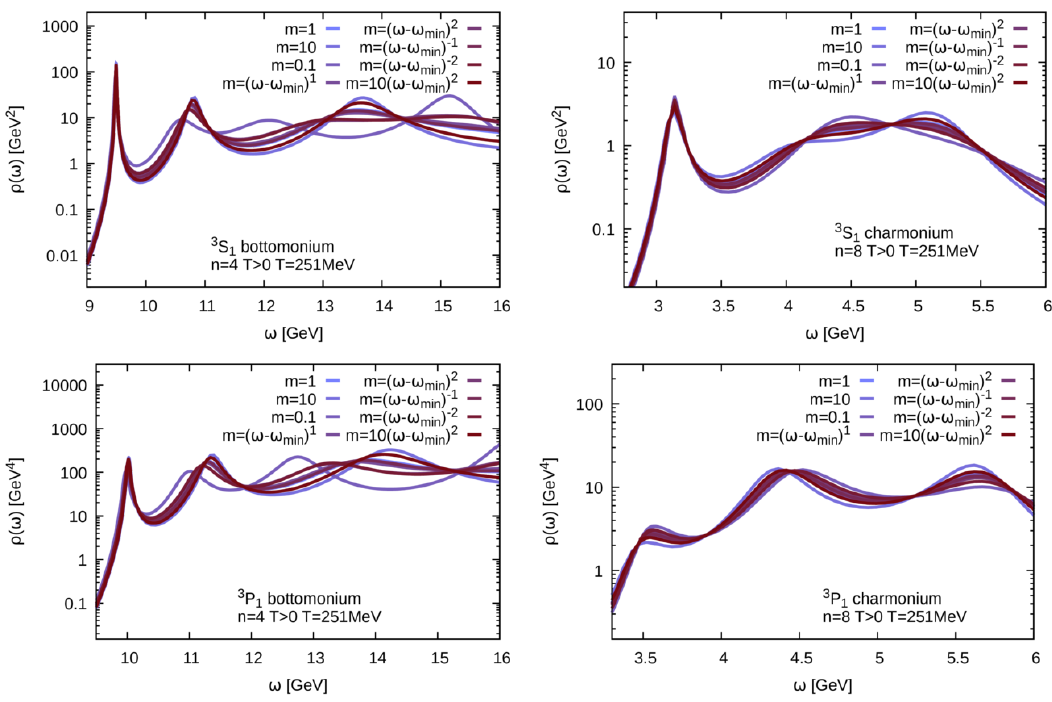
Figure 45 . Representative examples of the default model dependence of the spectral reconstruc- tions at T = 251MeV. Bottomonium results given on the left, charmonium on the right. We depict the S-wave channel in the top row, the P-wave channel in the bottom